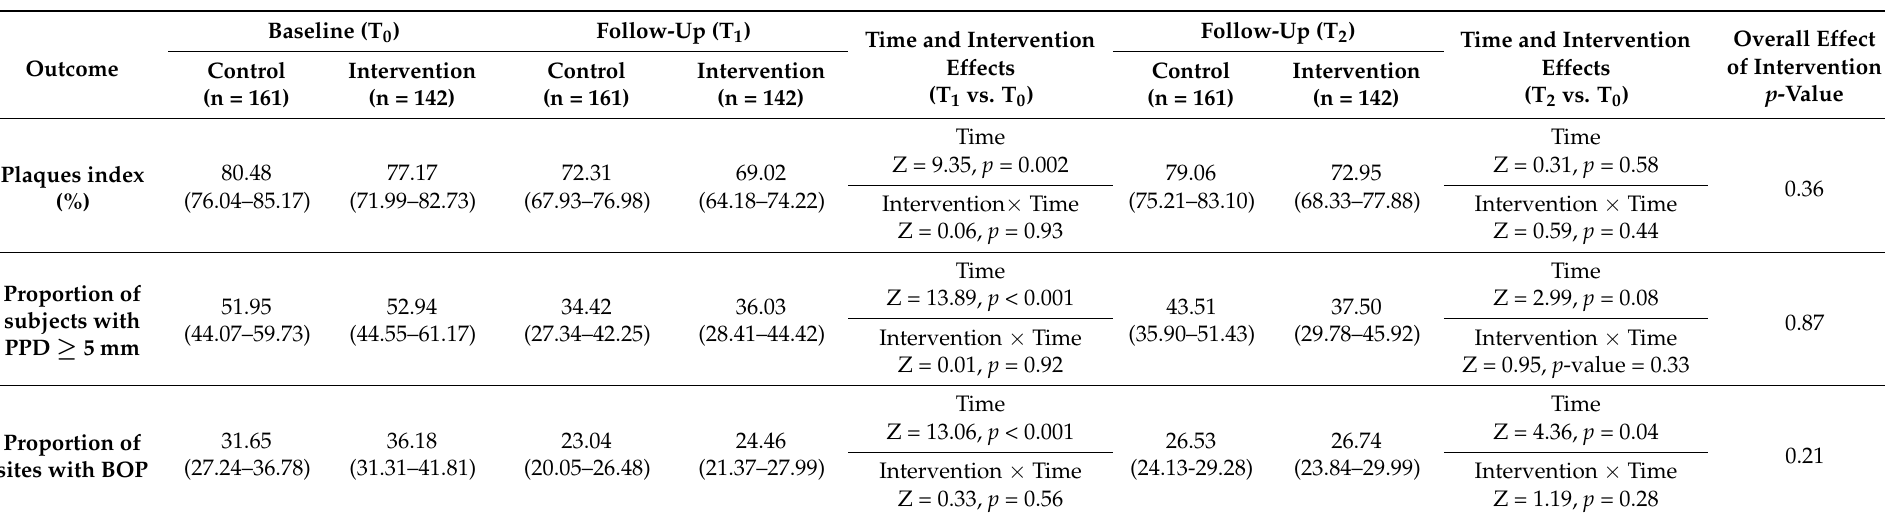
Table 3. Estimated marginal means and 95% confidence interval (95% C.I.) of clinical outcomes for the two-study groups at the baseline and the two follow up